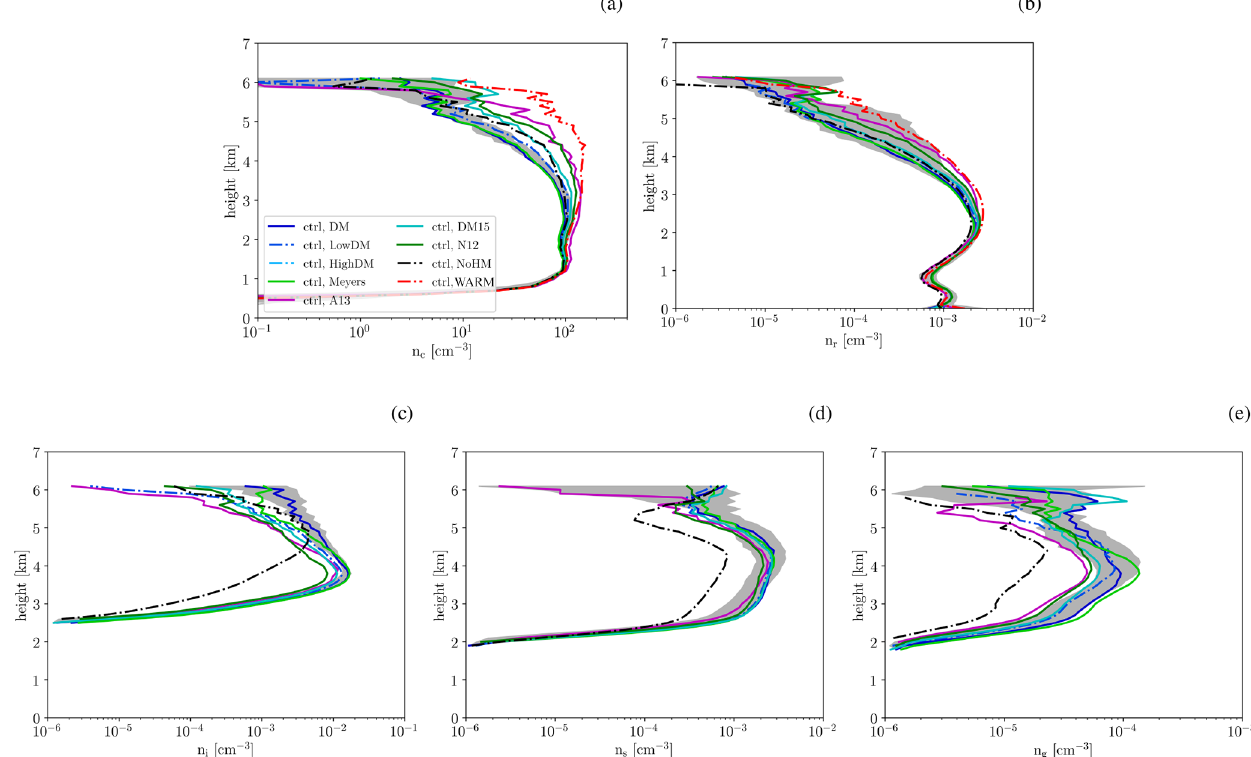
Figure 1. Average profiles of in-cloud number concentrations of (a) cloud droplets, (b) rain drops, (c) ice crystals, (d) snow, and (e) graupel. Different coloured lines show the profiles from simulations with different heterogeneous freezing parameterizations, different INP number concentrations, without a parameterization of the Hallett–Mossop process, and with warm cloud microphysics only (colours according to legend). The grey shading shows the spread of the average profiles in the 10-member high-resolution ensemble with the DeMott et al. (2010) heterogeneous freezing parameterization and a representation of the Hallett–Mossop process. The 0 ◦ C level is located at about 2.6km